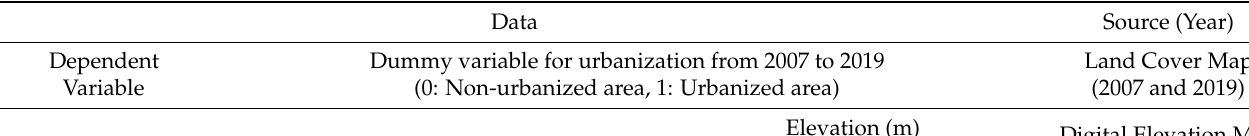
Table 1. Description of variables used in the study.